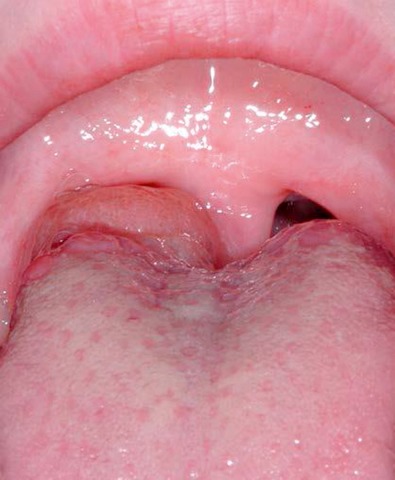
Lymphangioma of the right base of tongue. Anamnestically increasing, disturbed oropharyngeal phase.